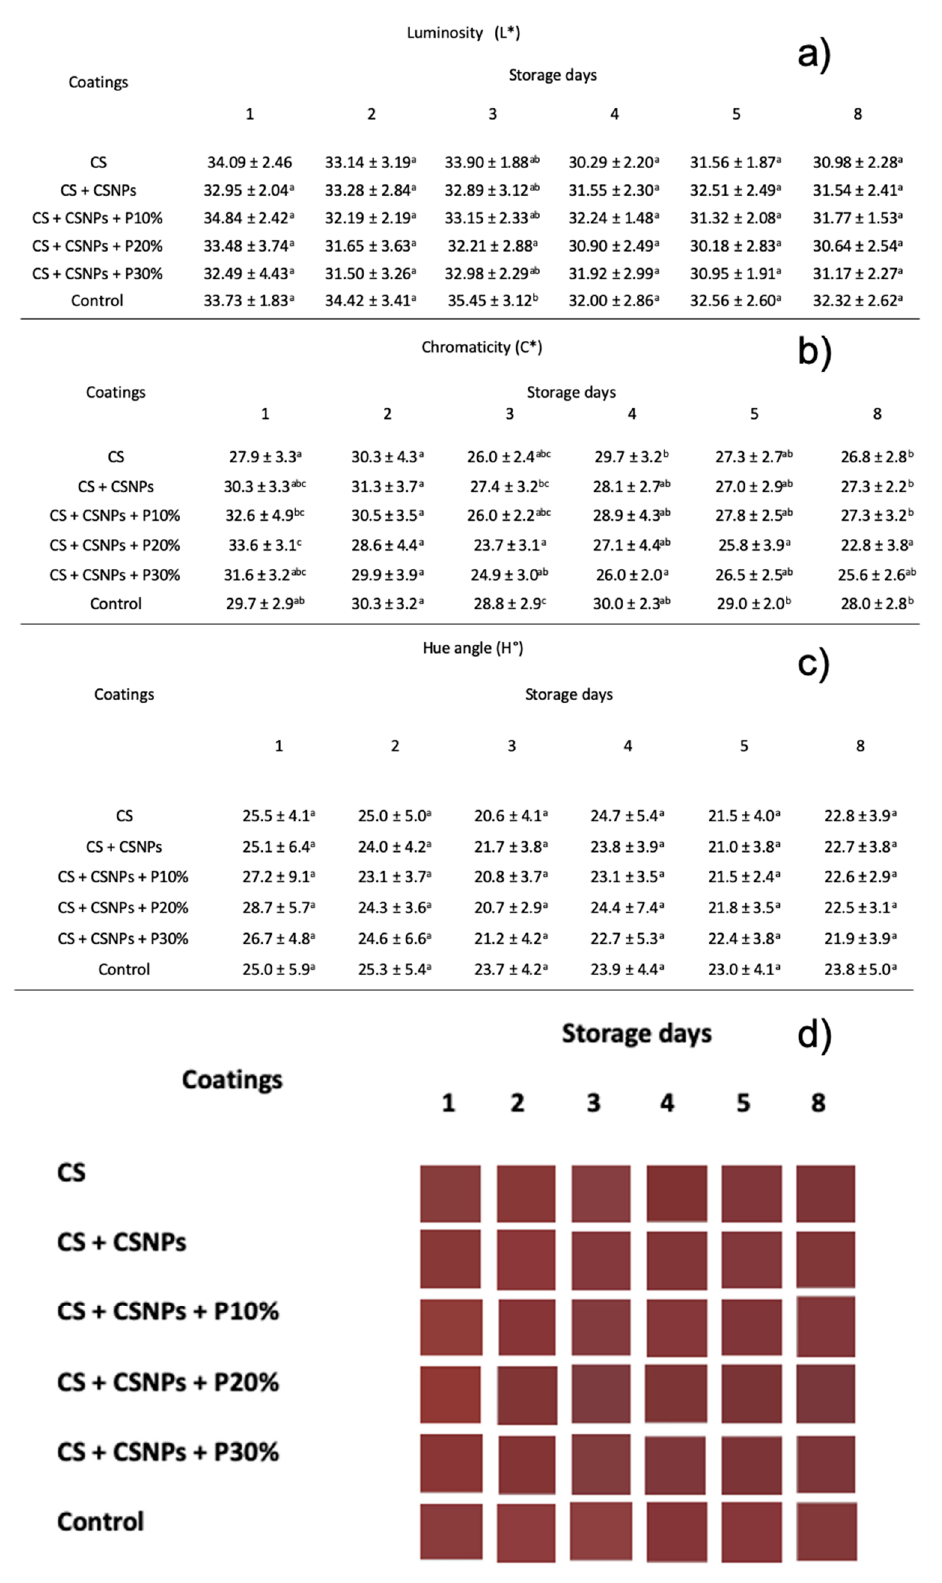
Figure 1. Change in color of strawberry fruit treated with nanostructured chitosan and propolis extract coatings during eight days of storage; ( a ) Luminosity values of strawberry fruit treated with nanostructured chitosan and propolis extract coatings. ( b ) Chromaticity values of strawberry fruit treated with nanostructured chitosan and propolis extract coatings. ( c ) Hue angle values of